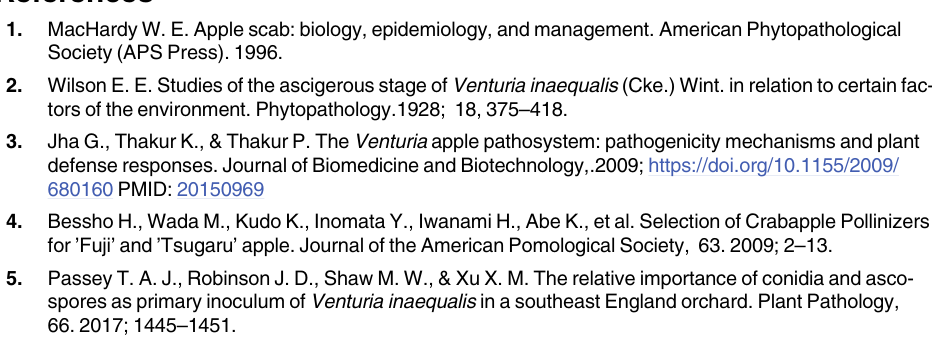
S1 Table. Detail information of the geographic location, apple cultivars were collected and used for